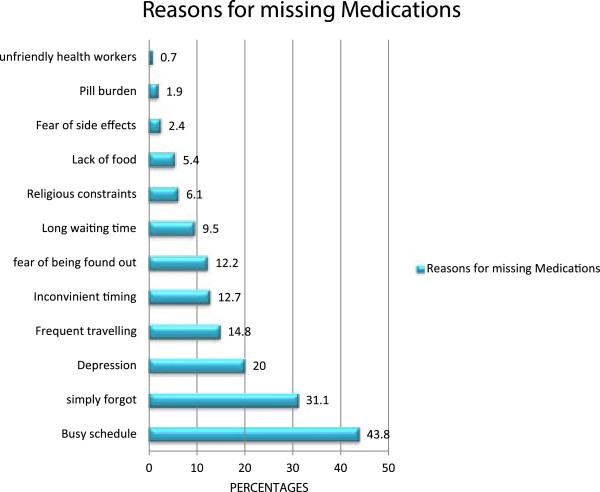
Reasons for missing/skipping medications.